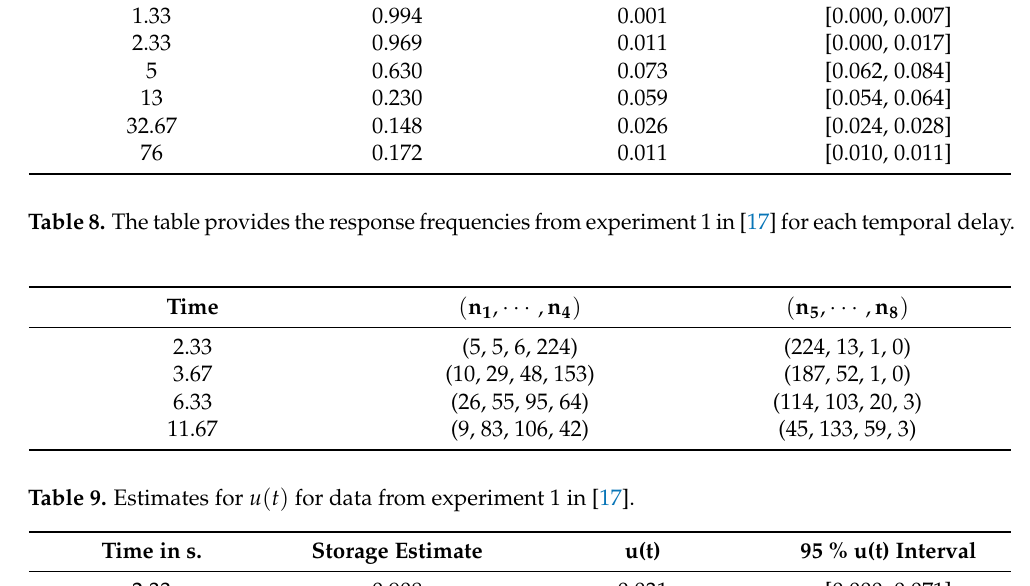
Table 7. Estimates for u ( t ) for data from experiment 2 in [17]. Time in s.